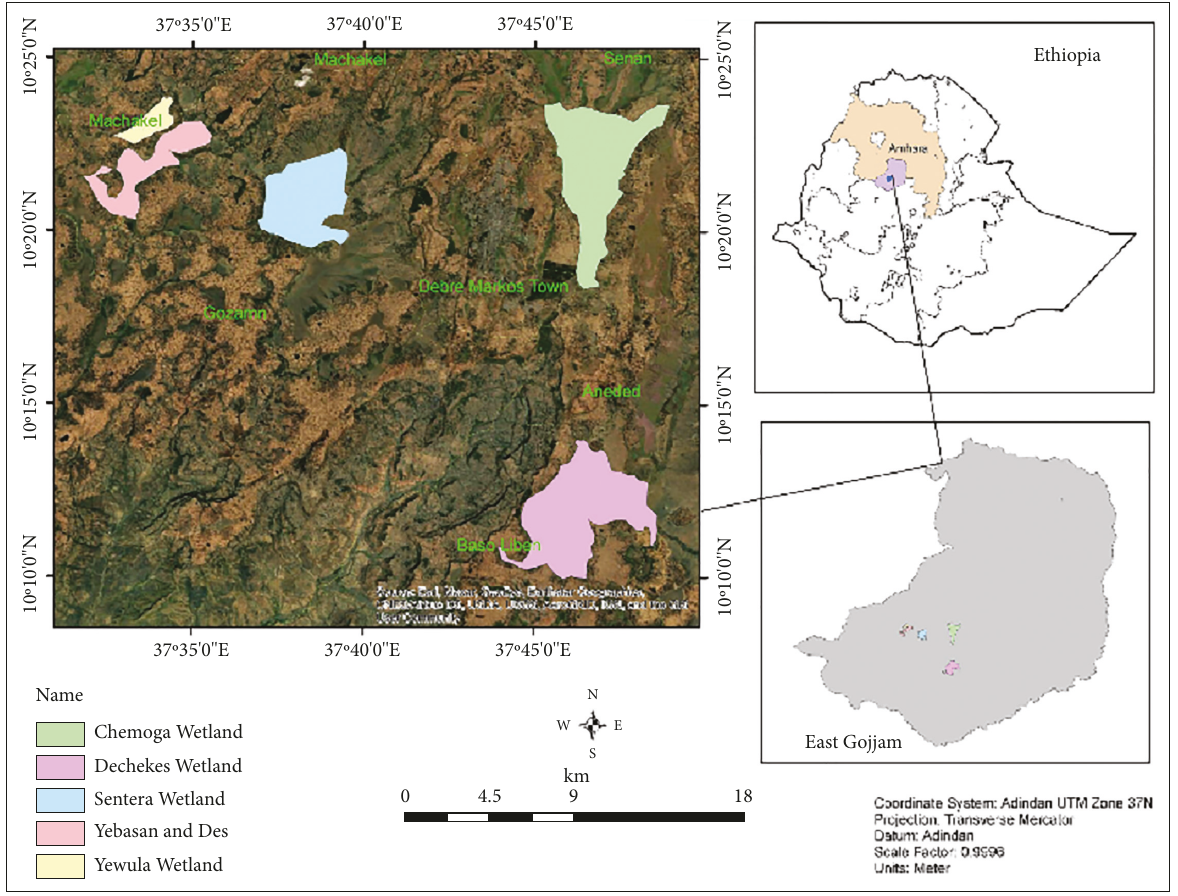
Figure 1: Location map of the study area.